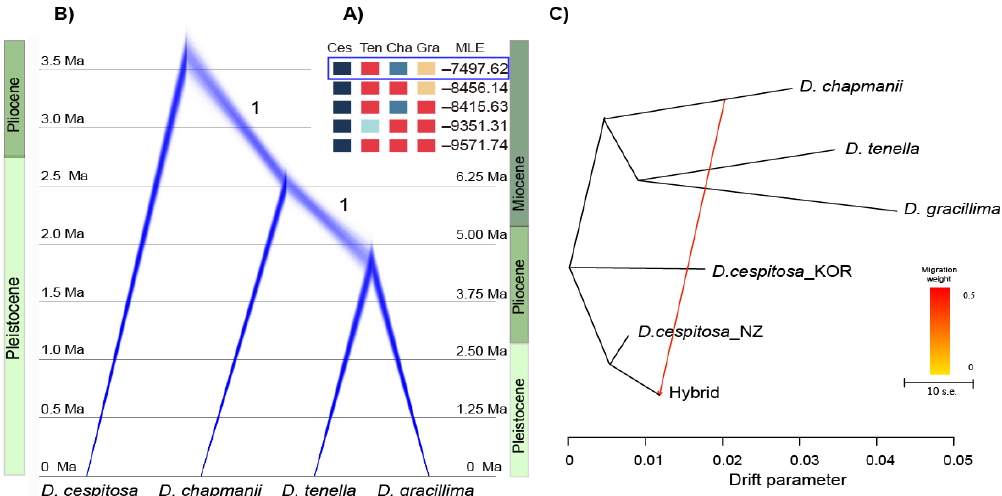
Figure 3. Results of coalescent-based phylogenetic inference. ( A ) Species delimitation models tests for D. cespitosa and three endemic species. Names of taxa follow Figure 2. MLE = marginal likelihood estimate. ( B ) The tree obtained for four Deschampsia species is shown as a cloudogram using Densitree. Posterior probabilities are presented for the relevant clades. The age was estimated by using average generation time estimates of Deschampsia (lower estimates for minimum two years, and upper estimates for maximum five years). ( C ) Treemix results based on 1600 unlinked SNPs in Deschampsia, excluding Australian D. cespitosa.